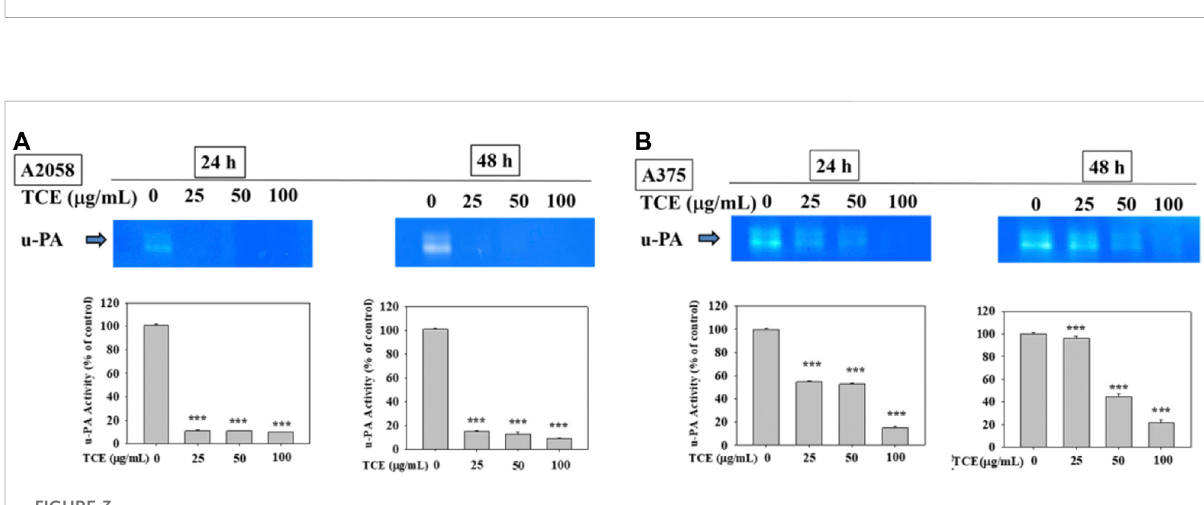
FIGURE 3 EffectsofTCEontheactivityofu-PA.A2058cellsandA375weretreatedwith(0,25,50,100 μ g/ml)ofTCEfor24 hand48 h,respectively,then subjected to gelatin and casein zymography to analyze the activities of u-PA (A , B) . The values represented the means ± SD of at least three independent experiments. Comparisons were performed using two-way ANOVA with post hoc Turkey ’ s test (*** p <